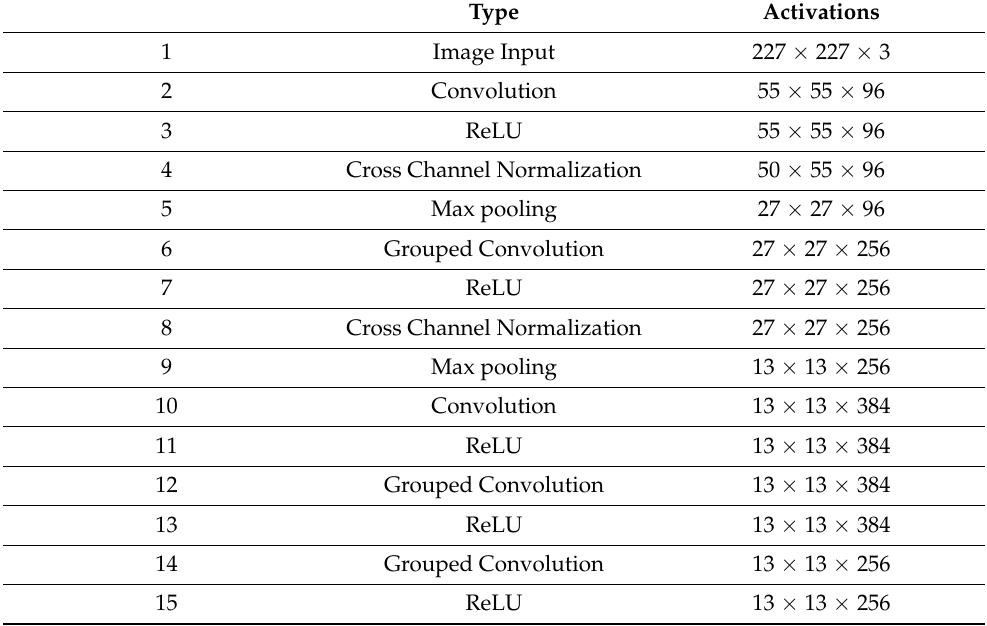
Table 4. The input and output of AlexNet